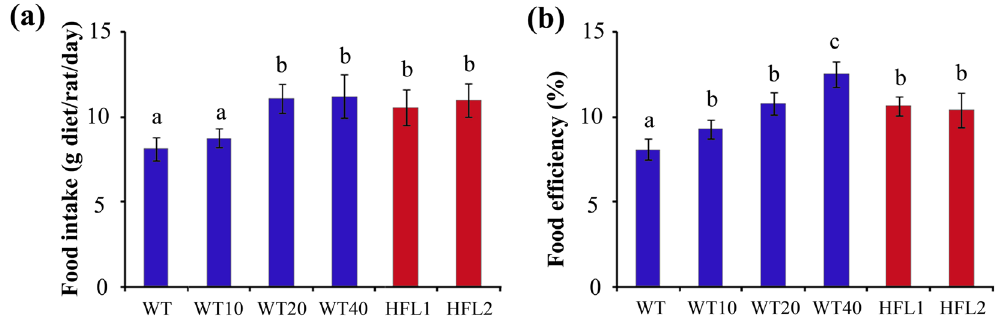
Figure 3. Food intake ( a ) and food efficiency ( b ) of rats fed different diets for 70 d. Error bars represent SD (n = 8). Different letters represent significant differences ( P <